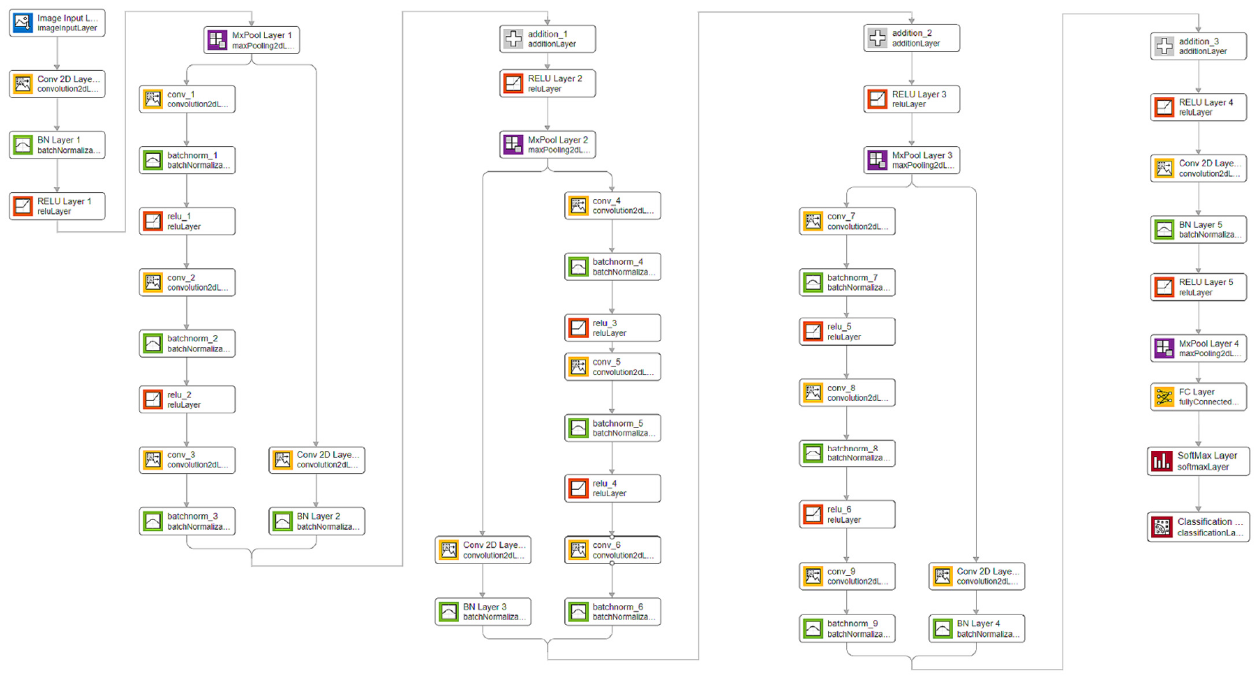
Figure 3. Flow diagram of the proposed methodology.